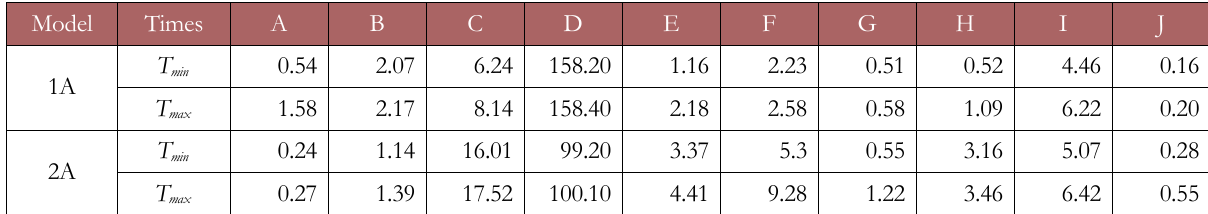
Table 15. Minimum and maximum times for sub-processes of two bicycle models